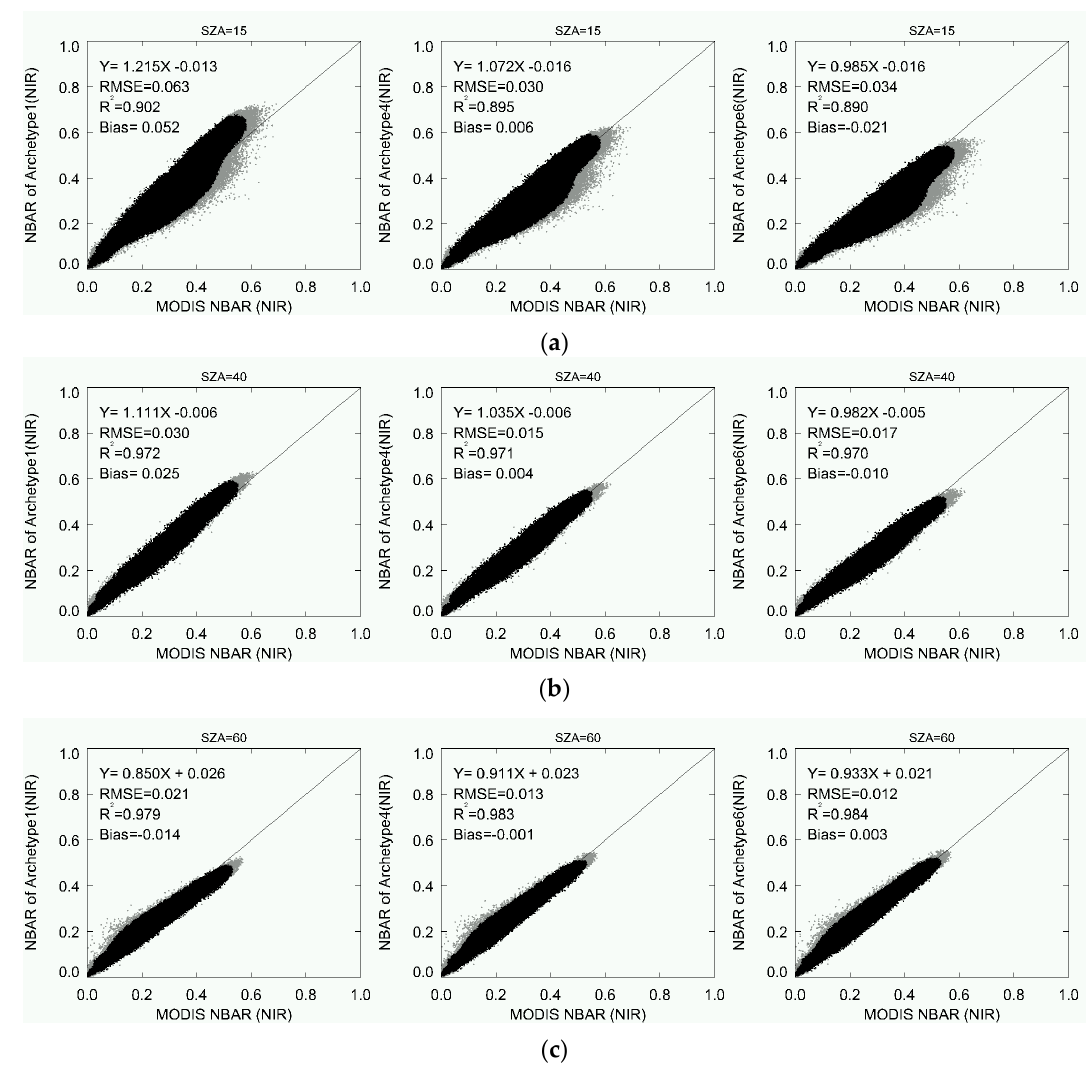
Figure 9. Comparison of MODIS NBARs with NBARs retrieved from different archetypal BRDFs in the NIR band. ( a – c ) refer to the result at solar zenith angle of 15°, 40°, and 60°. Three columns represent the result of archetypal BRDF Nos. 1, 4, and 6.